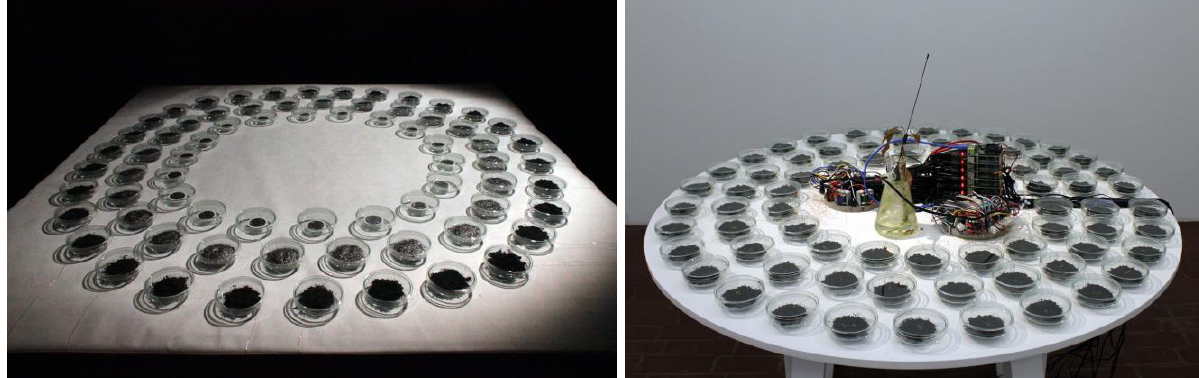
Figure 1 | Left: Writing Machine , 2011 at SONICA , Ljubljana. Right: Wr_t_ng M_ch_n_ , 2017 at Virtualities and Realities ,